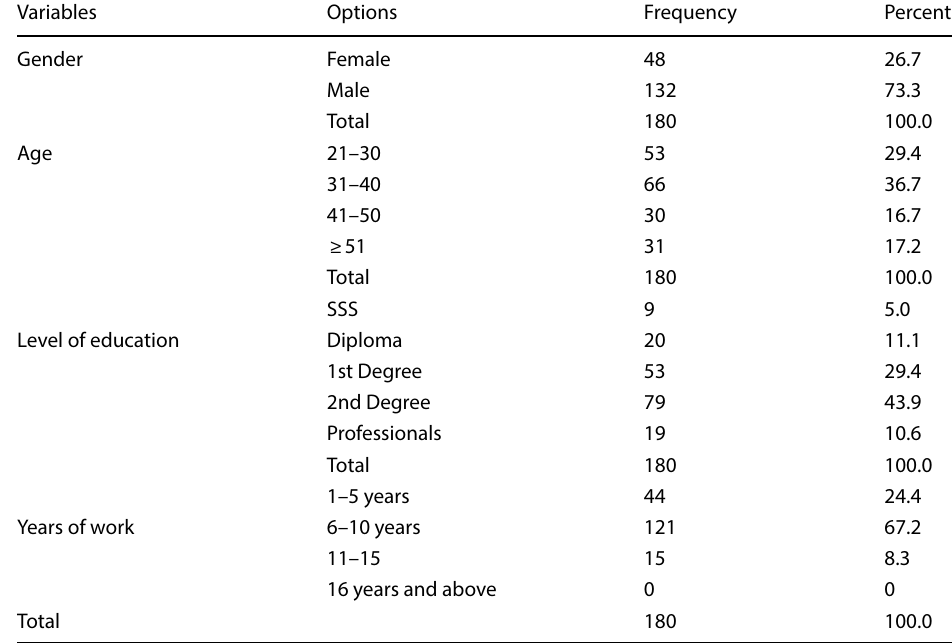
Table 2 Demographic characteristics of